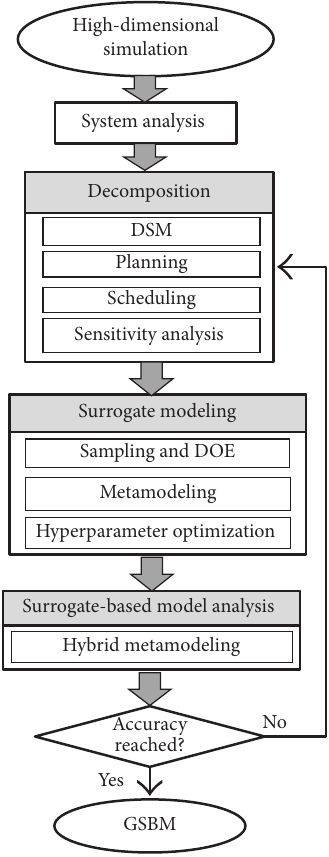
Figure 1: General structure for surrogate-based simulation devel-